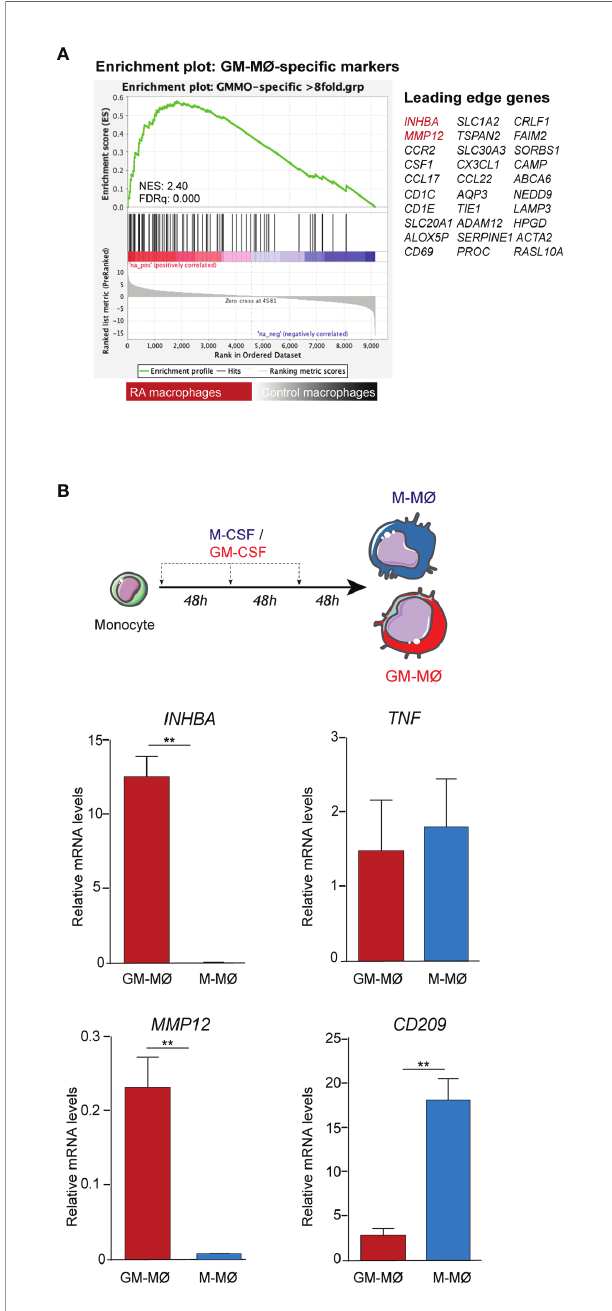
FIGURE 2 | Expression of polarization markers by RA macrophages and in-vitro generated monocyte-derived macrophages. (A) Gene set enrichment analysis (GSEA) on the ranked list of genes obtained from the comparison of the transcriptome of RA macrophages (RA mac) versus monocyte-derived macrophages (M-MØ) (GSE10500) using the set of genes with the highest GM-CSF-induced upregulation in monocyte- derived macrophages differentiated with GM-CSF (GSE68061). (B) INHBA , MMP12 , CD209 , and TNFA mRNA expression levels determined by qRT-PCR on monocytes differentiated with GM-CSF (GM-MØ) and M- CSF (M-MØ). Mean ± SEM of four independent donors are shown (* p < 0.05, ** p < 0.01, Student t